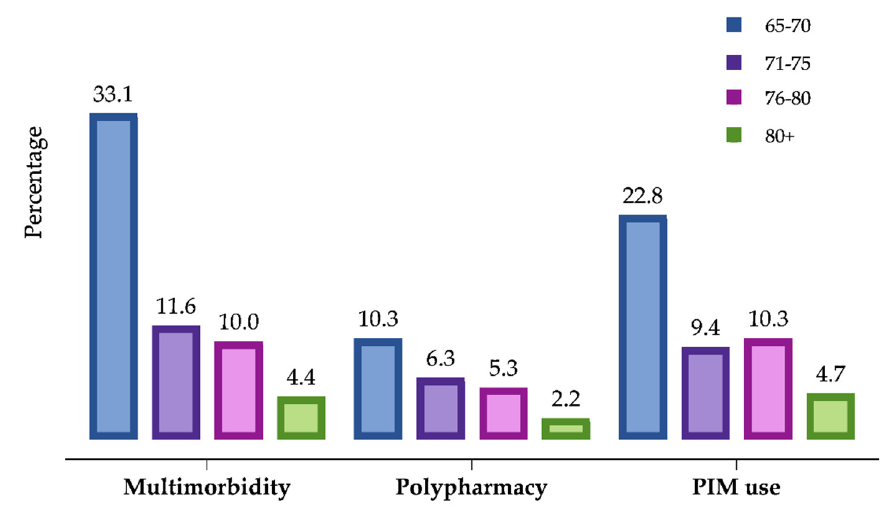
Figure 1. Distribution of multimorbidity, polypharmacy, and PIM use in older population.